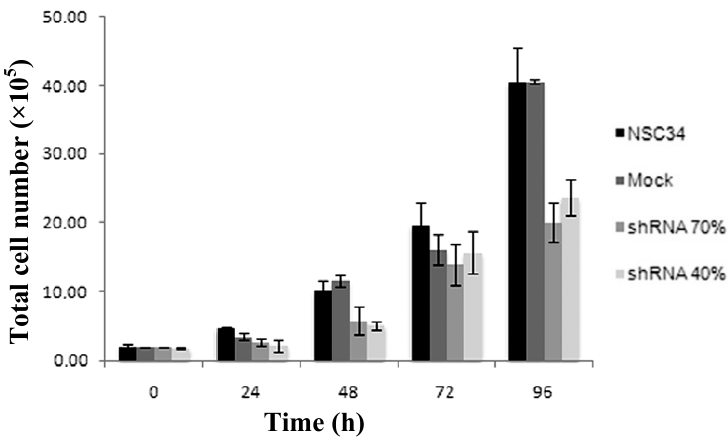
Figure 2. Viability of the stably frataxin-silenced NSC34 cells. Cell proliferation was evaluated by trypan blue exclusion assay. The data were expressed as number of cells that excluded the dye. Mean of three experiments in